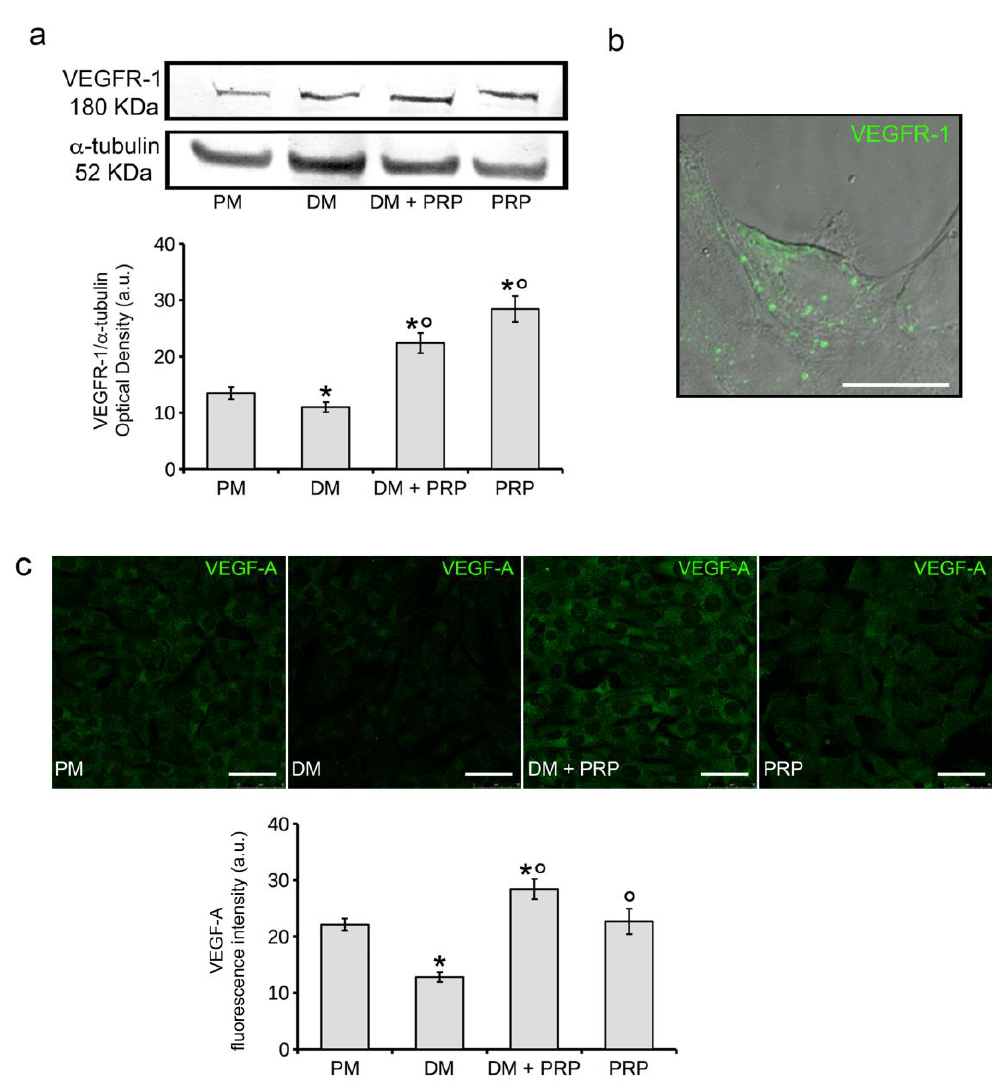
Figure 4. Fibroblast VEGFR-1 and VEGF-A expression. NIH/3T3 fibroblastic cells were cultured in differentiation medium (DM, low serum medium plus 2 ng/mL TGF- β 1) in the absence or presence of 1:50 diluted PRP (DM + PRP) or in the presence of 1:50 serum-free medium diluted PRP (PRP). Cells cultured in proliferation medium (PM) served as control undifferentiated cells. ( a ) Western blotting analysis of VEGFR-1 expression. Histogram shows the densitometric analysis of the bands normalized to α -tubulin. ( b ) Representative superimposed differential interference contrast (DIC) and confocal fluorescence images of control cells immunostained with antibodies against VEGFR-1 showing the cellular localization of VEGFR-1; the staining (green) is mainly localized at the cell surface. Scale bar: 20 µ m. ( c ) Representative confocal fluorescence images of the cells immunostained with antibodies against VEGF-A. Scale bar: 50 µ m. Histogram shows the densitometric analysis of the intensity of VEGF-A fluorescence signal performed on digitized images. Data shown are mean ± S.E.M. and represent the results of at least three independent experiments performed in triplicate. Significance of difference: * p < 0.05 vs. PM; ° p < 0.05 vs. DM.